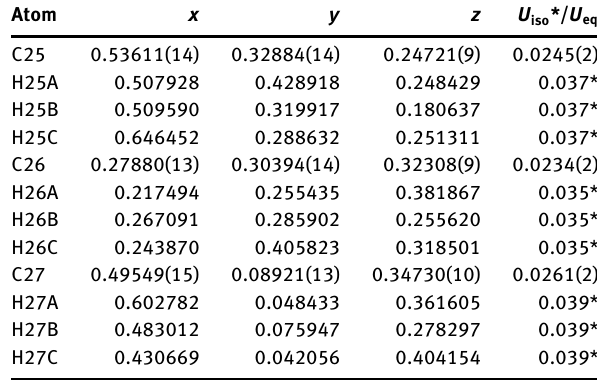
Table 2: Fractional atomic coordinates and isotropic or equivalent isotropic displacement parameters (Å 2